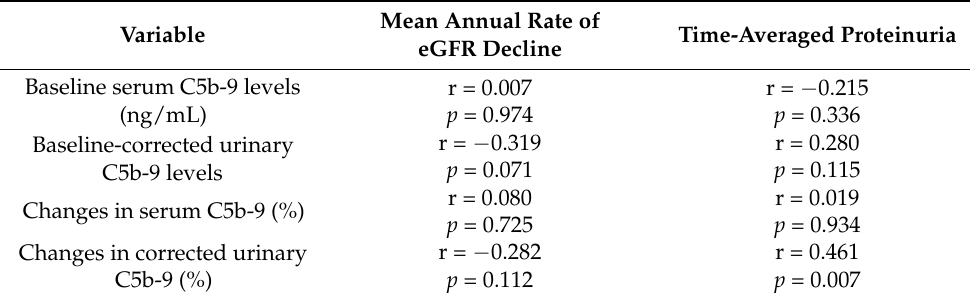
Table 4. Correlation among baseline and changes in serum and corrected urinary C5b-9 levels after medical